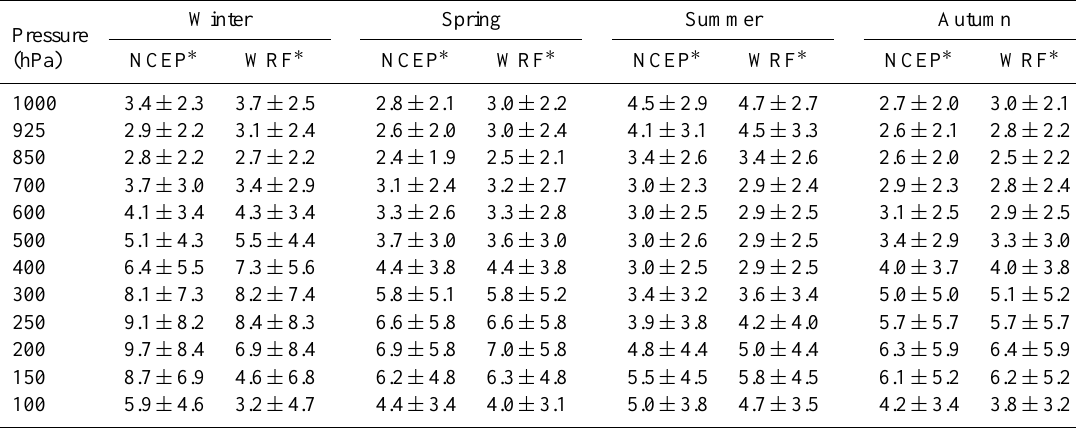
Table 6. Same as the Table 5 but for the meridional wind